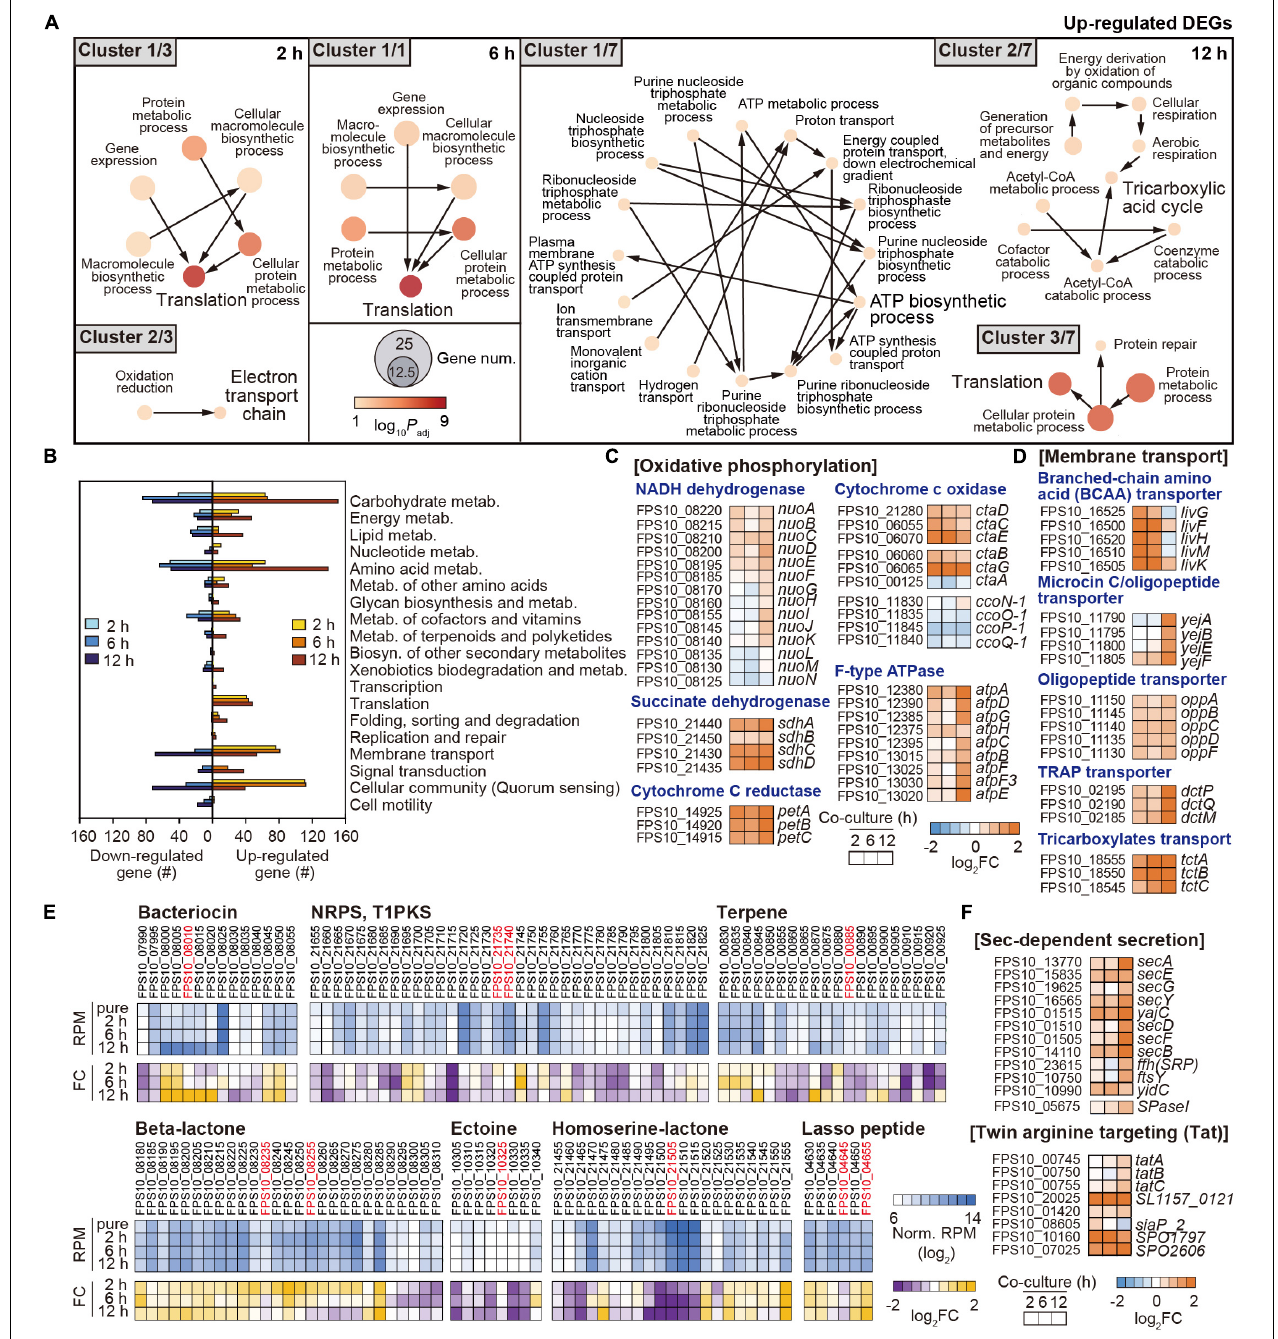
FIGURE 5 | Functional changes in Pseudoruegeria sp. by co-culture. (A) Functional clustering through GO enrichment analysis from upregulated DEGs in Pseudoruegeria sp. are displayed by culture time. The node size indicates the gene number, and the color key indicates the log 10 p -value of DEG. (B) KEGG analysis from the DEGs in Pseudoruegeria sp. are also shown during co-culture. (C,D) Transcriptome fold changes (FC) of the genes related to oxidative phosphorylation (C) and membrane transport (D) are displayed by the co-culture time using a heatmap. (E) RNA expression and its changes in secondary metabolite-synthesizing gene clusters in Pseudoruegeria sp. are shown using a heatmap, according to the co-culture time. (F) Transcriptome fold changes of the bacterial secretion systems, the Sec-dependent secretion (Sec) and twin-arginine targeting (Tat) systems, are shown by co-culture time using a heatmap. FC indicates the fold change in transcriptome after